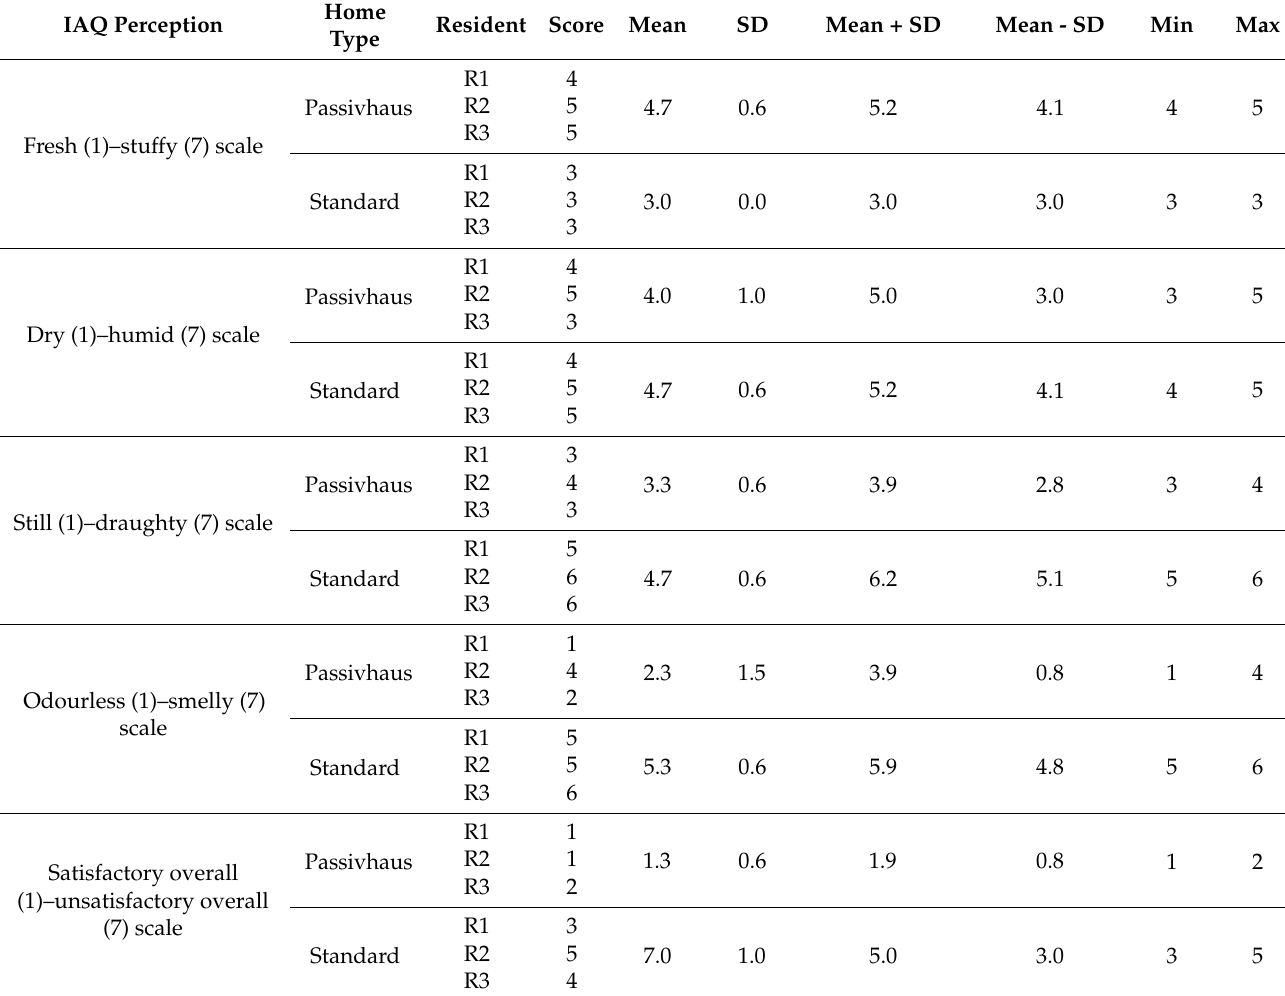
Table 5. Statistical analysis of the IAQ perceptions during summer for both homes. Source: Authors. IAQ